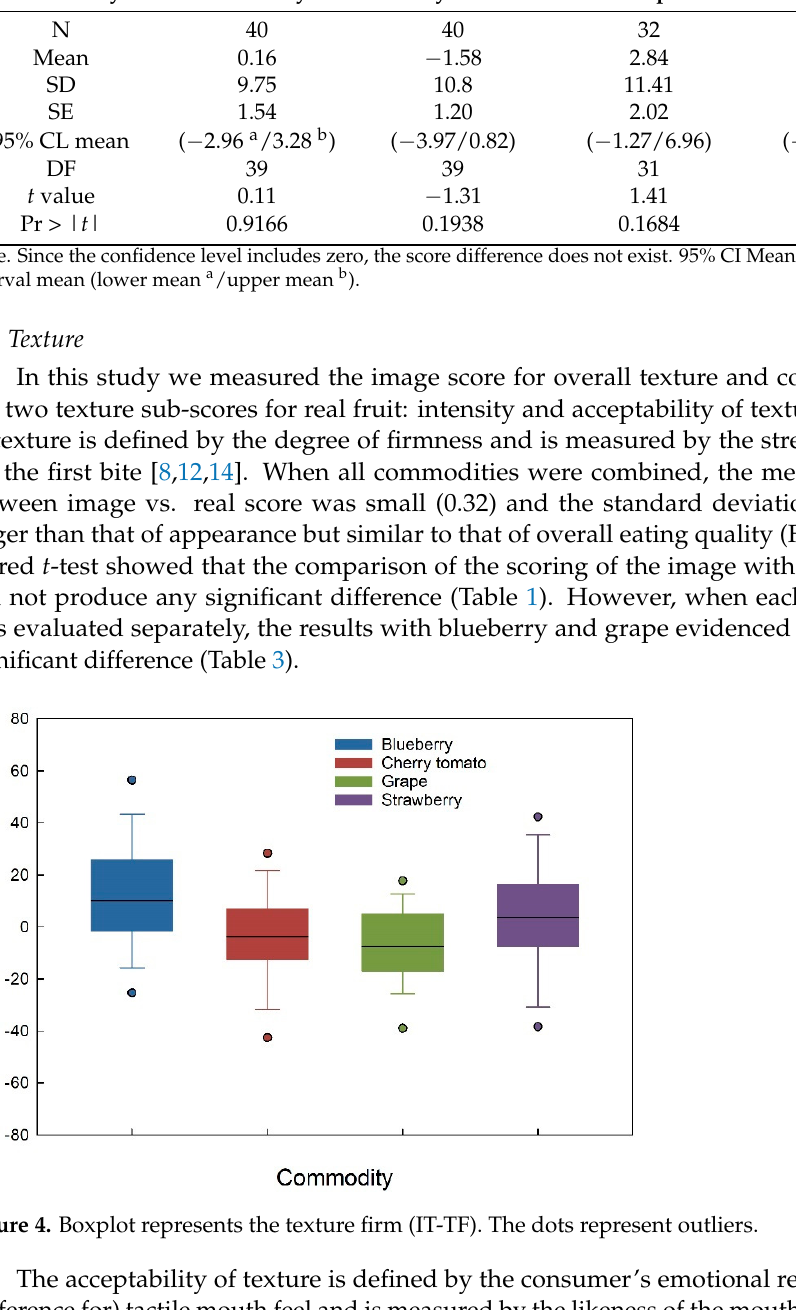
Table 2. Paired t -tests comparing appearance mean scores of images to real produce. IA-A Commodity Blueberry Cherry Tomato Grape Strawberry N 40